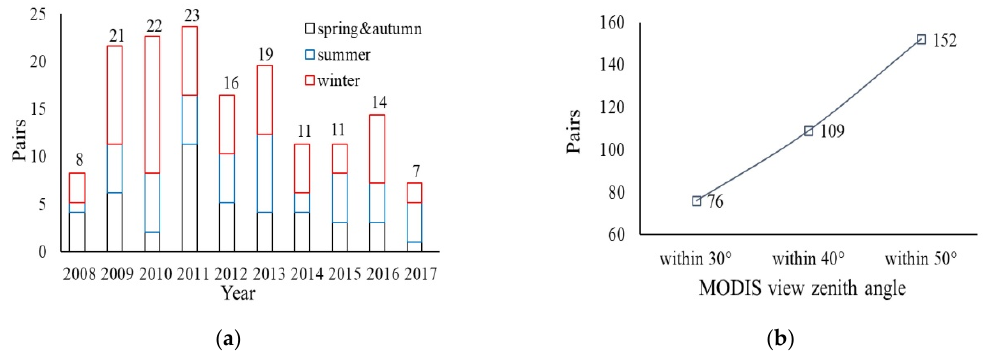
Figure 3. E ff ective matched-image pairs and statistics. ( a ) The annual e ff ective data volumes; ( b ) image Figure 3. Effective matched-image pairs and statistics. ( a ) The annual effective data volumes; ( b ) image pairs pairs corresponding with MODIS-view zenith corresponding with MODIS-view zenith angle.